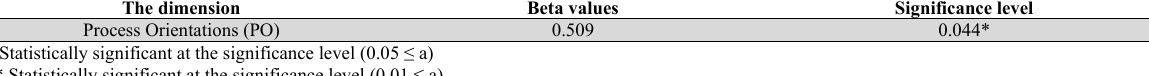
Analysis of regression results for the direct impact of using information systems software on supply chain performance in Saudi industrial companies The dimension Beta values